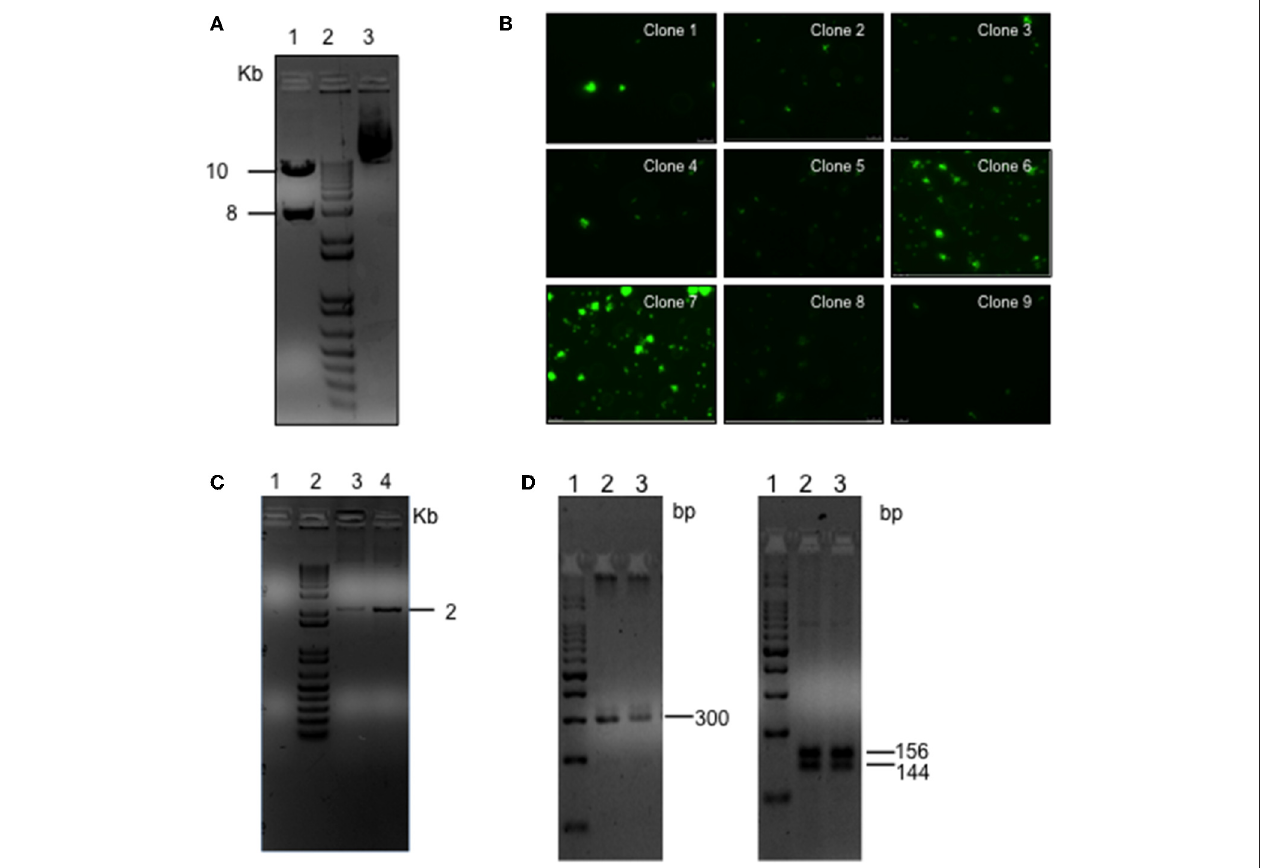
FIGURE 2 | Generation of the L. braziliensis co-expressing eGFP and LUC. (A) Agarose gel electrophoresis of pIRSATeGFP_LUC following Swa I digestion (lane 1), 1Kb marker (lane 2), Undigested circular plasmid (lane 3). (B) Fluorescent microscopy of transgenic L. braziliensis clones. (C) Agarose gel electrophoresis of PCR product amplified using primers complementary to the Nourseothricin resistance marker (SAT) present in the of integration cassette and complimentary to the rDNA locus of the L. braziliensis genome (outside the cassette), indicative of eGFP-LUC integration, SSU locus (18s gene). PCR was performed using genomic DNA purified from WT Lb (lane 1) or from transgenic Lb (clones 6 and 7) (lane 3 and 4, respectively). (D) Agarose gel electrophoresis of PCR product amplified using primers complimentary to the ITS-1 locus using genomic DNA purified from WT- Lb (lane 2) or eGFP-LUC Lb (transfected clone 7) (lane 3) (Left panel). Hae III digestion of ITS-1 PCR product. WT-Lb (lane 2) or transgenic Lb (transfected clone 7) (lane 3) (right